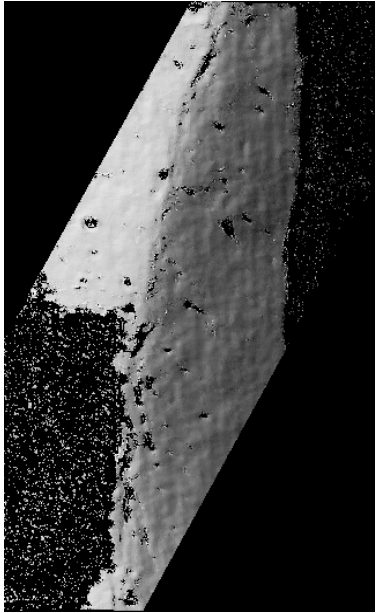
Figure 4. Shaded relief of the DTM at SR1 site derived from the first stereo pair